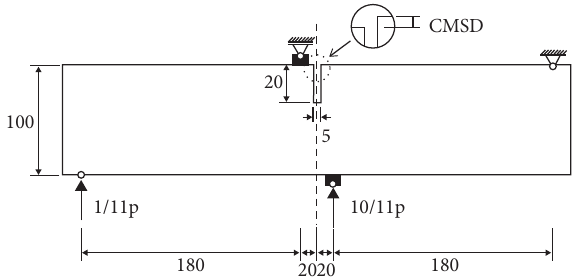
Figure 15: Single-notched four-point beam.